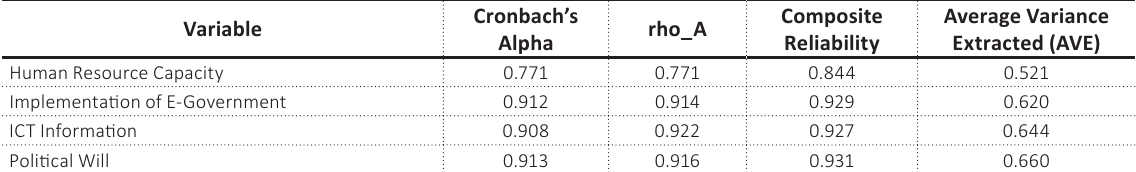
Source: Data analyzed using